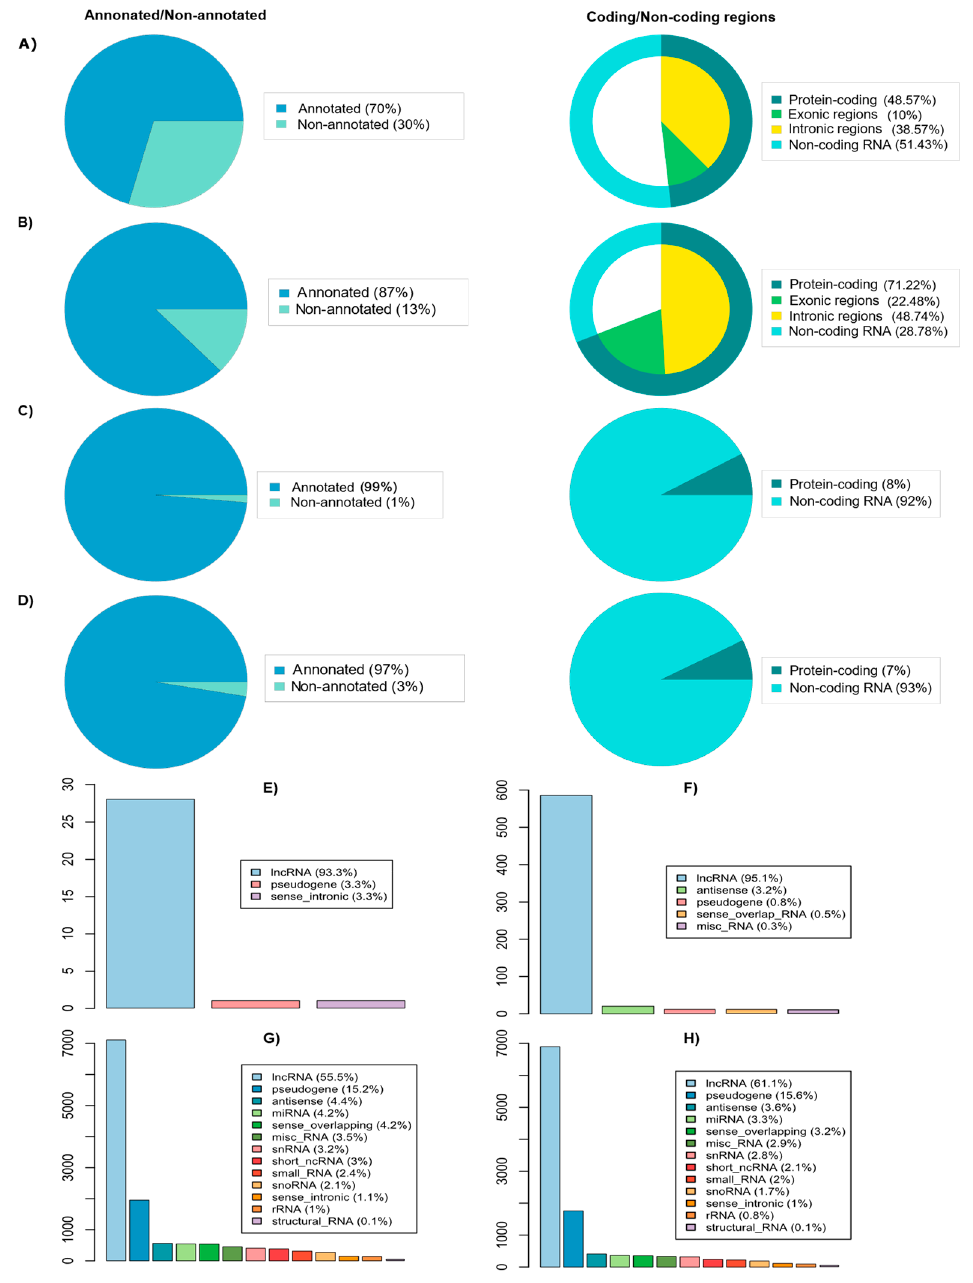
Figure 5. Linking genomic variants to coding and non-coding genes. ( A ) Somatic point mutation hotspots; ( B ) GWAS SNPs; ( C ) duplicated CNVRs; ( D ) deleted CNVRs. The left panel shows the percentage of genomic variants associated with the genes (annotated regions) or no genes associated with the genomic variants (non-annotated regions). The right panel shows the fraction of these genomic variants that are protein-coding or non-coding genes. The greater fraction of hotspot regions and CNVRs are located in non-coding genes, while less than 30% of GWAS SNPs are located in non-coding genes. ( E – H ) show the percentage of linking of different types of genomic variants, including ( E ) somatic point mutation hotspots; ( F ) GWAS SNPs; ( G ) duplicated CNVRs; ( H ) deleted CNVRs into noncoding RNA. y -axis represents the number of different types of RNA associating with genomic variants.